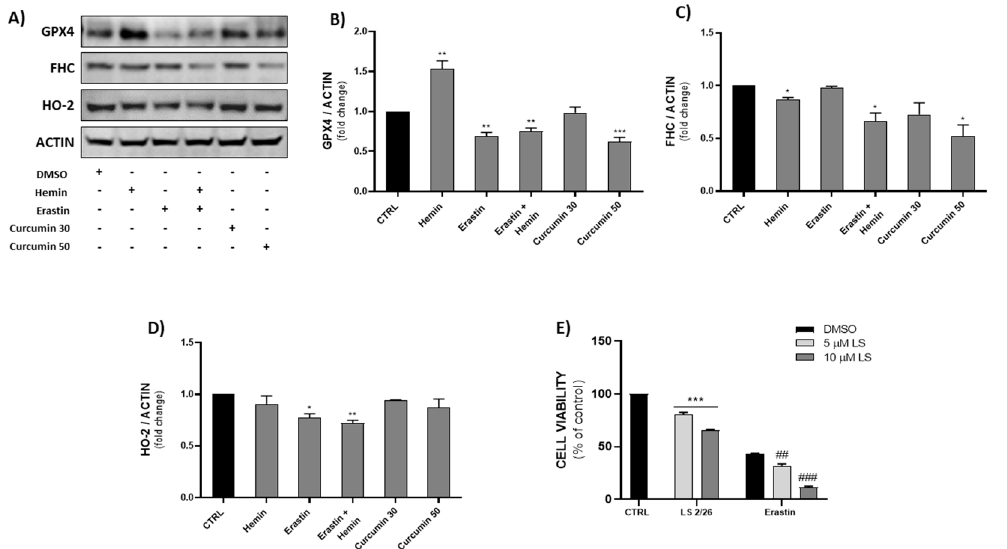
Figure 5. ( A – D ) Effects of hemin (5 µM), erastin (5 µM), the erastin/hemin combination and curcumin (30, 50 µM) on GPX4, FHC and HO-2 protein expression levels (* p < 0.05, ** p < 0.005, *** p < 0.0005 vs. CTRL). ( E ) Assessment of the effects of the HO-2 selective inhibitor LS 2/26 on cell viability (*** p < 0.0005 vs. CTRL; ## p < 0.005, ### p < 0.0005 vs. erastin). The results are expressed as means ± SEM.